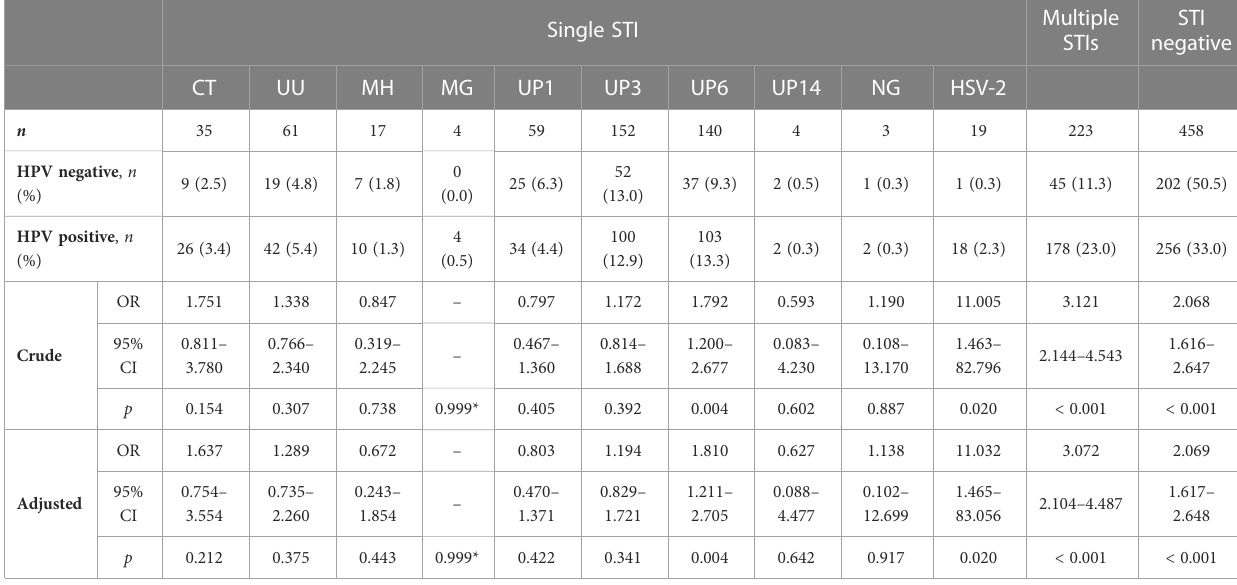
TABLE 1 Infection rates of STIs in groups with or without HPV